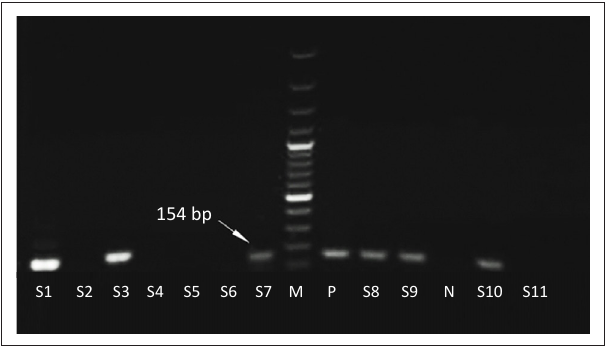
M, DNA marker 100 bp; P, Positive control; N, Negative control; bp, base pairs. S1, caecal tonsil; S2 and S11, spleen; S6 and S7, lungs; S4 and S10, thymus; S5 and S9, trachea; S3 and S8, bursa of Fabricius. FIGURE 7: Detection of 793/B serotype by nested polymerase chain reaction in different tissue samples.